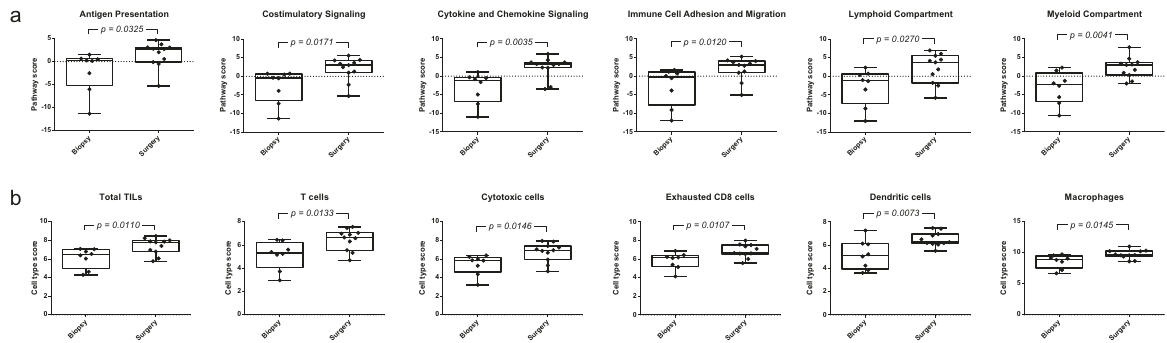
Fig. 3 Increase of in fl ammatory signature in EOC surgery samples from patients with no/partial response to NACT. a Several pathways associated with immune regulation are stimulated by NACT, including antigen presentation, costimulatory signaling, cytokine and chemokine signaling, immune cell adhesion and migration, lymphoid compartment, and myeloid compartment. Pathway scores were used to summarize data from a pathway ’ s genes into a single score. b Different immune cell subsets show increased abundance in surgery samples after NACT, including total TILs, T cells, cytotoxic cells, exhausted CD8 cells, dendritic cells, and macrophages. Cell-type scores were calculated as the average log2 normalized expression of each cell ’ s marker genes. As cell-type scores are calculated in log2 scale, an increase of 1 on the vertical axis corresponds to a doubling in abundance. The value for each EOC sample is shown, biopsy samples n = 8 and surgery samples n = 11. p Values were determined using the unpaired t test for samples with a Gaussian distribution and Mann – Whitney test for samples without normal